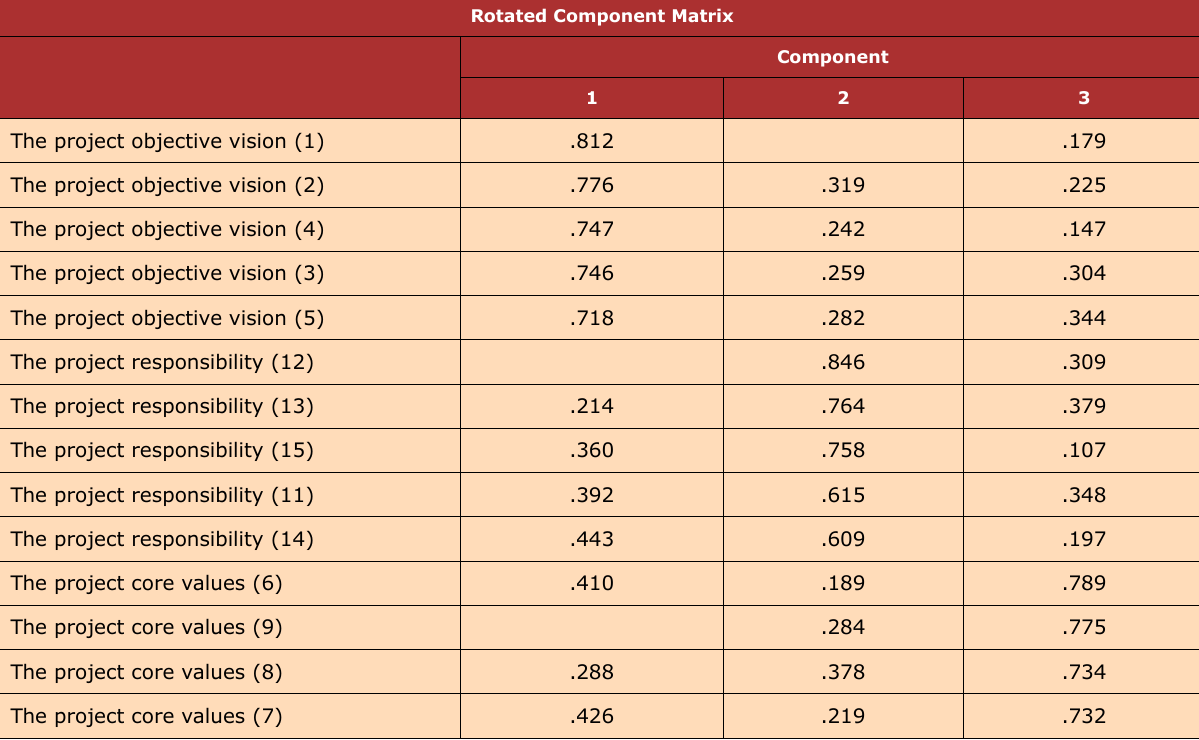
Table 8. Factor analysis of the sense of mission